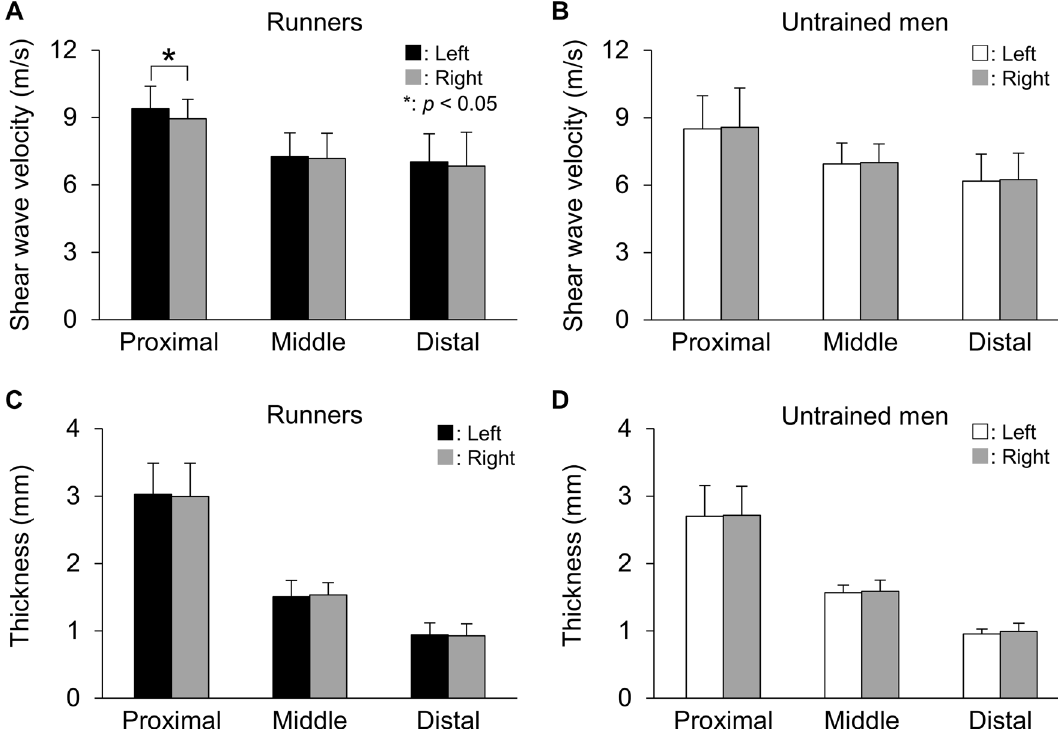
Figure 1. Bilateral differences in SWV and thickness of runners and untrained men. Data are shown as means ± the bilateral differences in runner’s feet can be confirmed, this provides an indication of a threshold of mechani- cal stress that causes adaptation of PF and foot arch functions. A profound understanding of PF adaptability is essential for improvements in their performance as well as prevention of plantar fasciitis. Therefore, the purpose of this study was to investigate the bilateral differences in mechanical and morpho- logical properties of PF and foot dimensions in track distance runners, as contrasted to untrained individuals. We hypothesized that track distance runners have bilateral differences in PF SWV, thickness, and the foot arch height, and that runners show sizable differences in the left to right (L/R) ratios of measured variables as com- pared to untrained individuals. Results In runners, SWV at the proximal site was significantly higher in left (9.4 ± 1.0 m/s) than right foot (8.9 ± 0.9 m/s) ( p = 0.021, d = 0.813), but not at the middle ( p = 0.782, d = 0.073) or distal sites ( p = 0.554, d = 0.138) (Fig. 1). Even